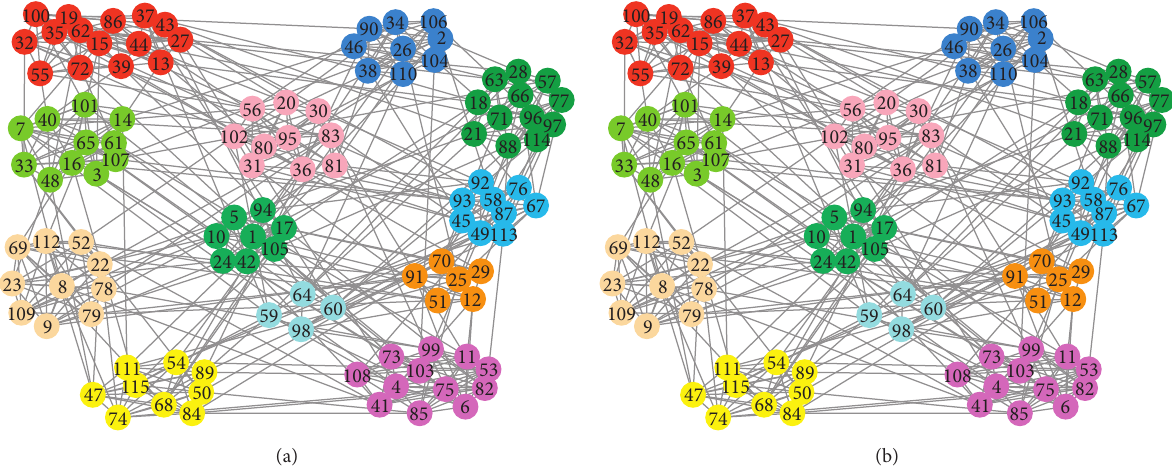
Figure 8: The football game schedule network: (a) the ground-truth community structure; (b) the community structure obtained by the proposed